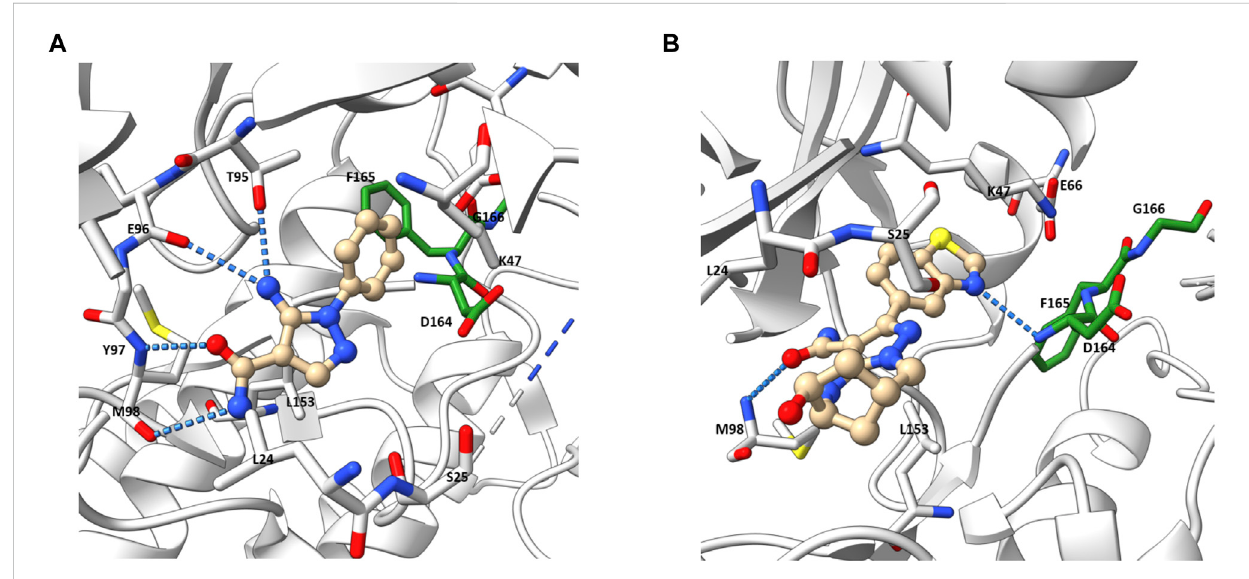
Co-crystal structure of RIPK2 in complex with NSC 11602 (PDB ID: 6SZE) (A) and 6 (PDB ID: 6UL8) (B)